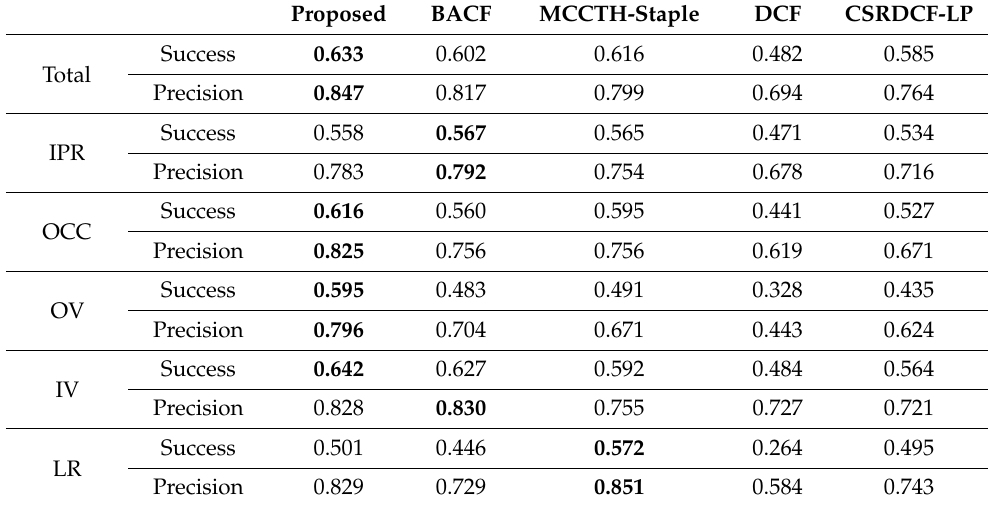
Table 7. Overall Performance Evaluation Results for Attributes of OTB-100 Benchmark